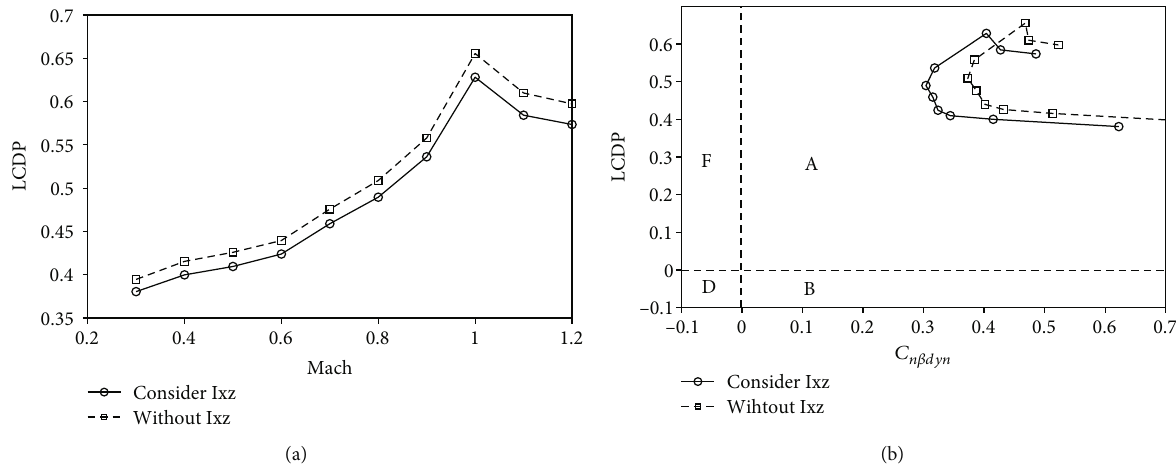
Figure 6: LCDP and Weissman chart analysis results. (a) LCDP results with and without the inertia product. (b) Weissman chart results with and without the inertia product (region A: no departure; regions B – F: increasing departure and spin susceptibility).